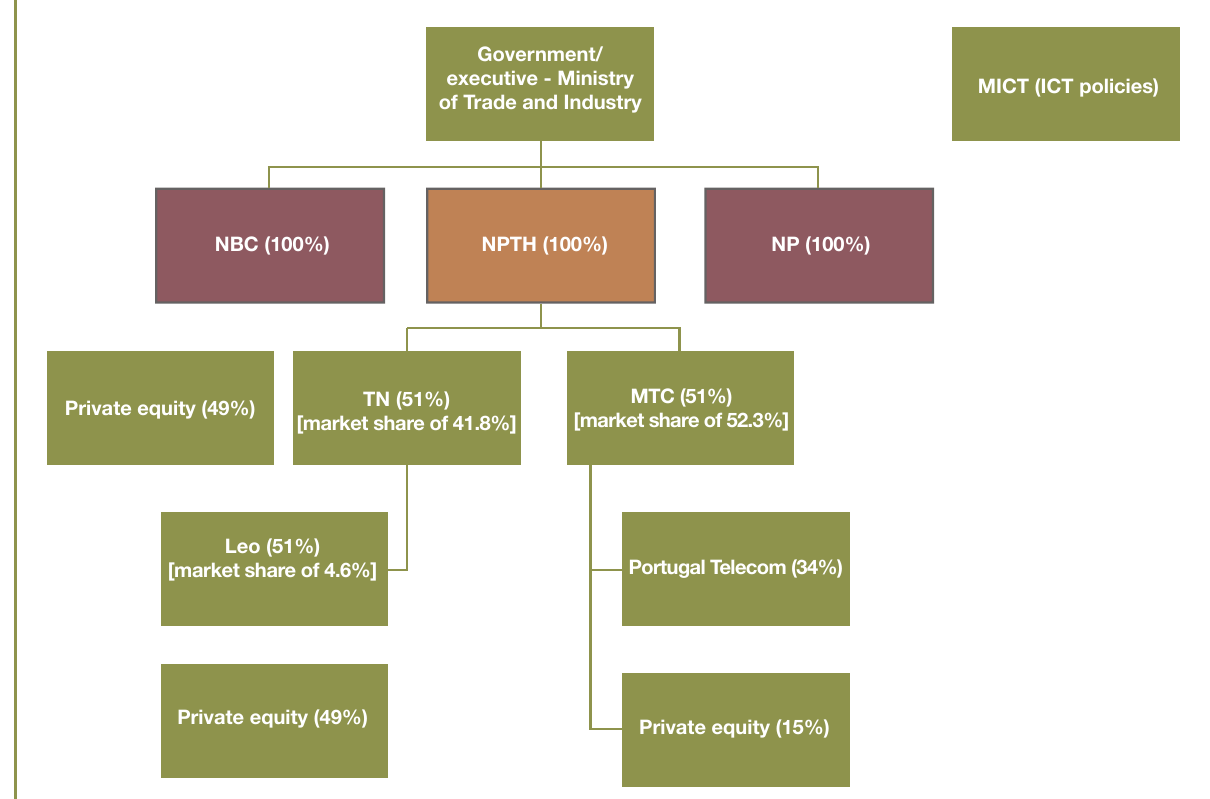
FIGURE 5: PROPOSED GOVERNMENT OWNERSHIP STRUCTURE AND ROLE SEPARATION OF